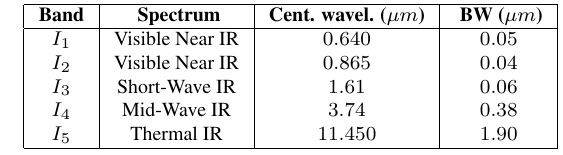
Table 4: VIIRS I-channels, the corresponding spectral regions, center wavelength and bandwidth (BW). Table 5: Mean shifts in x ( µ x ) and y ( µ y ) directions (estimated absolute geolocation errors) for both sensors.